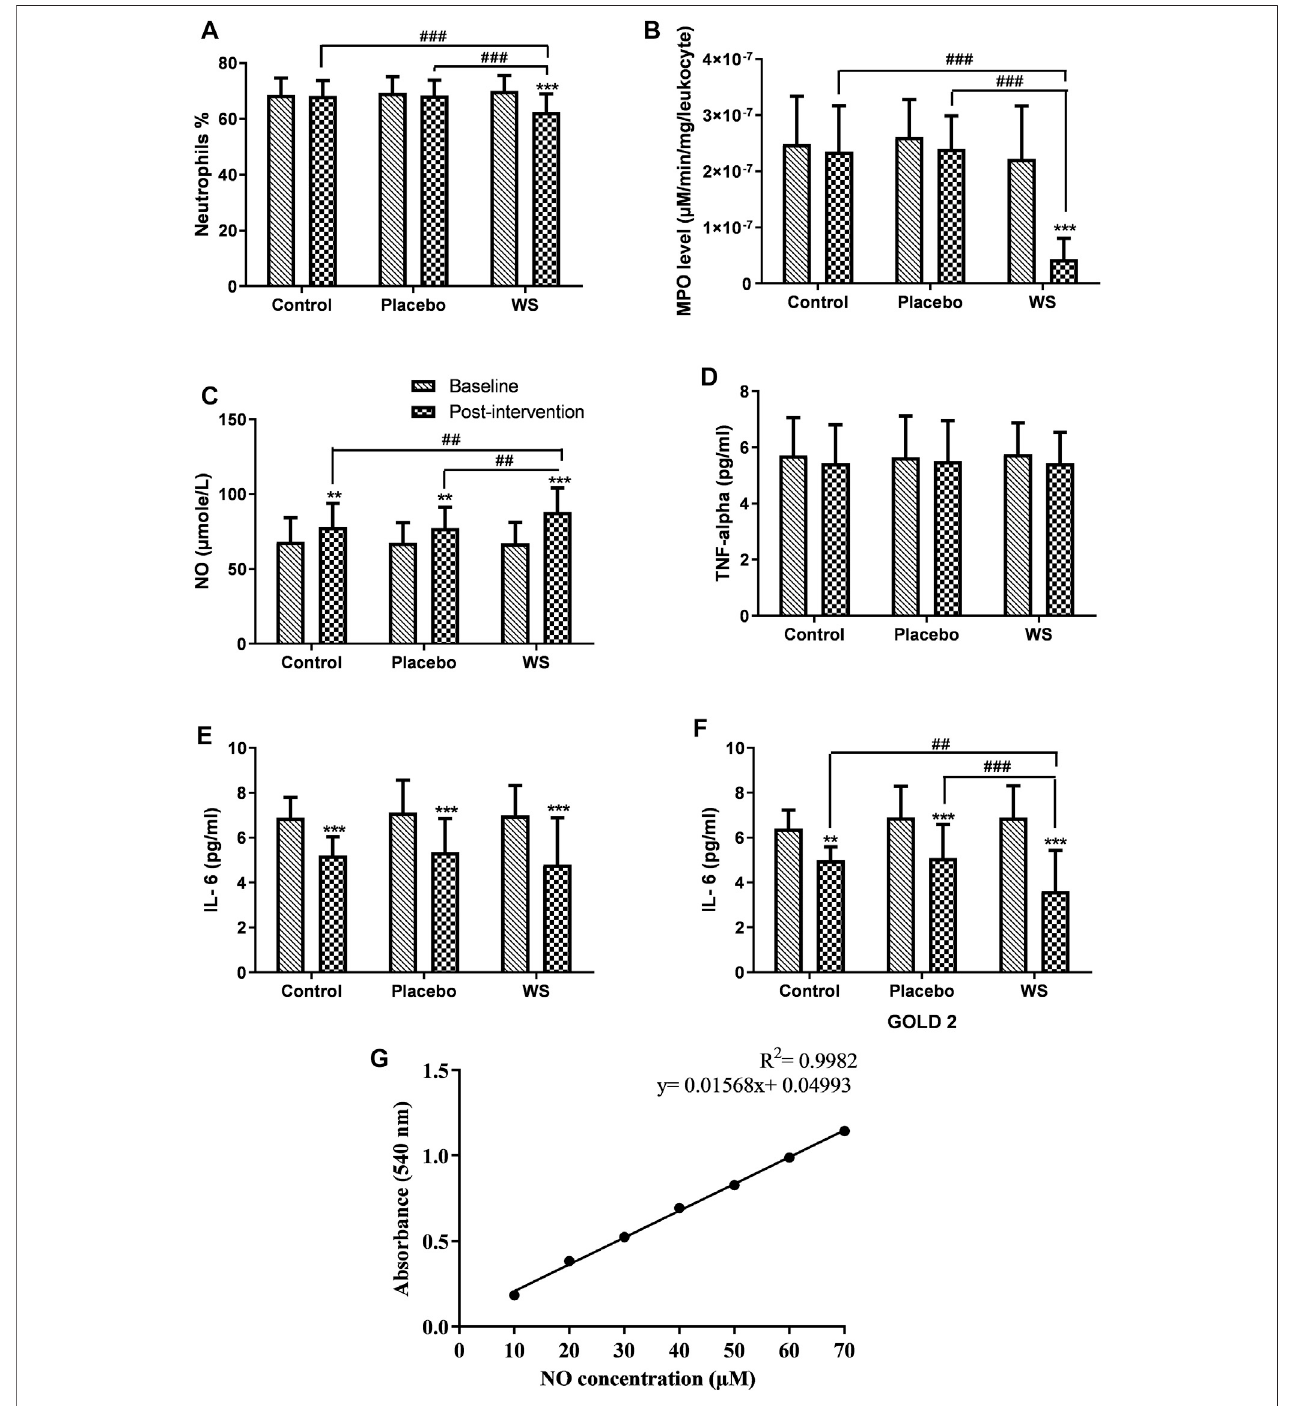
FIGURE 6 | Effect of interventions on systemic in fl ammation of patients: Mean (A) neutrophils %, (B) MPO level (in blood leukocytes), (C) NO concentration, (D) TNF-alpha, (E) IL-6 (GOLD 2and 3 combined), (F) IL-6 (GOLD 2category patients)in blood ofpatients at the baseline and at theend ofthe study, (G) Standard curve of NO concentration. ** p ≤ 0.01, *** p ≤ 0.001, compared with baseline. ## p ≤ 0.01, ### p ≤ 0.001.